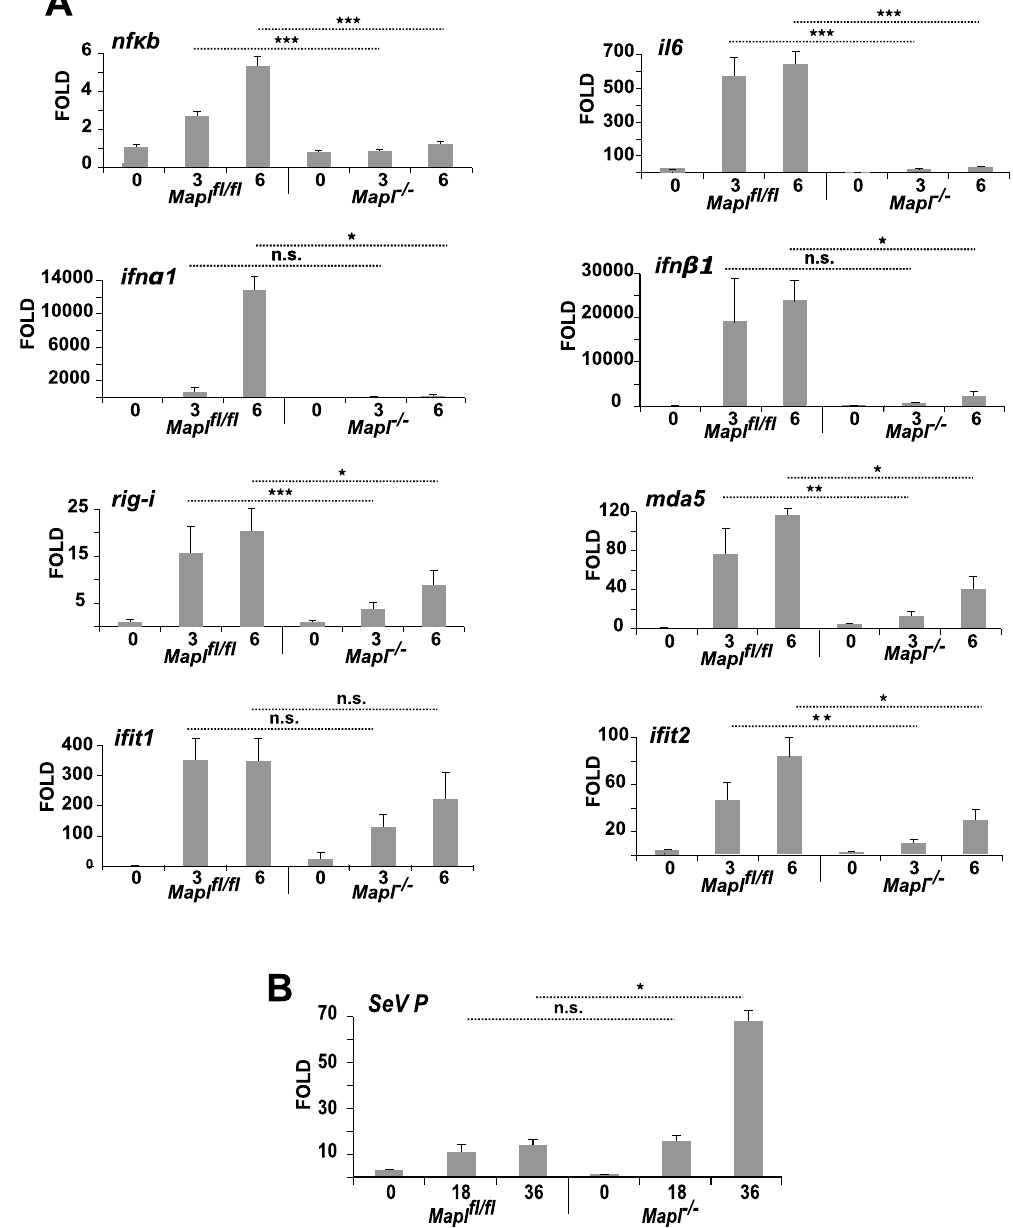
Figure 2. Impaired transcriptional response with the loss of MAPL. ( A ) Mapl fl/fl and Mapl − / − MEFs were left untreated or infected with Sendai virus (150 HAU/mL) for 3 or 6 hours, RNA was extracted, and Nf-kB, IL6, IFN α 1, IFN β 1, RIG-I, MDA5, IFIT1 and IFIT2 levels were measured by quantitative real-time PCR (n = 3). (B) MEFs were left untreated or infected with Sendai virus (150 HAU/mL) for 18 or 36 hours, RNA was extracted, and Sendai virus Protein P level was measured by quantitative real-time PCR (n = 3). Results are expressed as the median induction, comparing Mapl − / − to Mapl fl/fl . * P < 0.05, ** P < 0.01 and *** P < 0.001, n.s.,